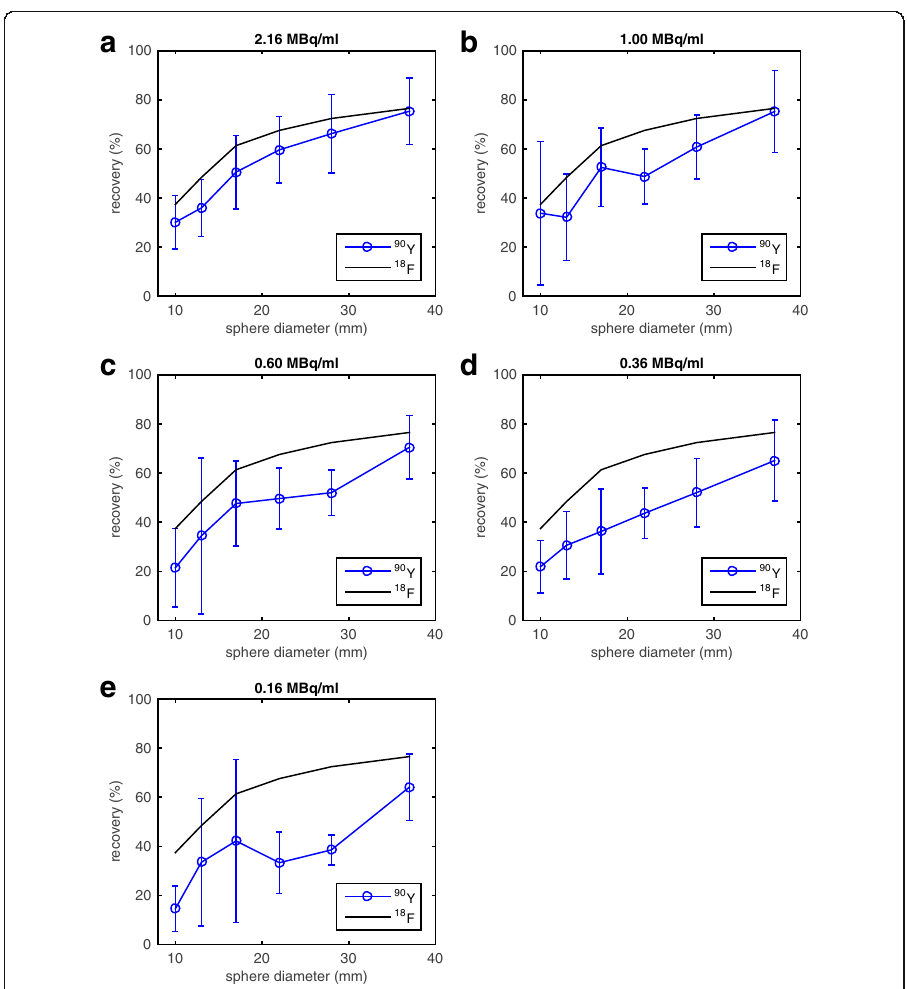
Fig. 5 a – e Recovery coefficients as a function of hot sphere size from five different hot sphere activity concentrations across all sites. Each point represents the mean RC and error bars represent one standard deviation across the eight sites. The COV for each sphere size and hot sphere activity concentrations are shown in Table 3. Measurements from one site ’ s 18 F measurements (54.4 MBq) are shown in black